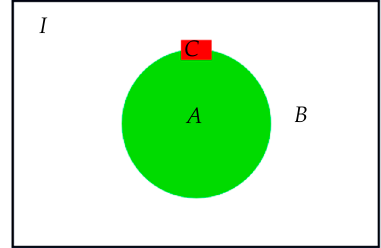
Figure 2. Schematic diagram to illustrate the sensitive area ( C ) of defects ( A ) in the specimen ( I ).